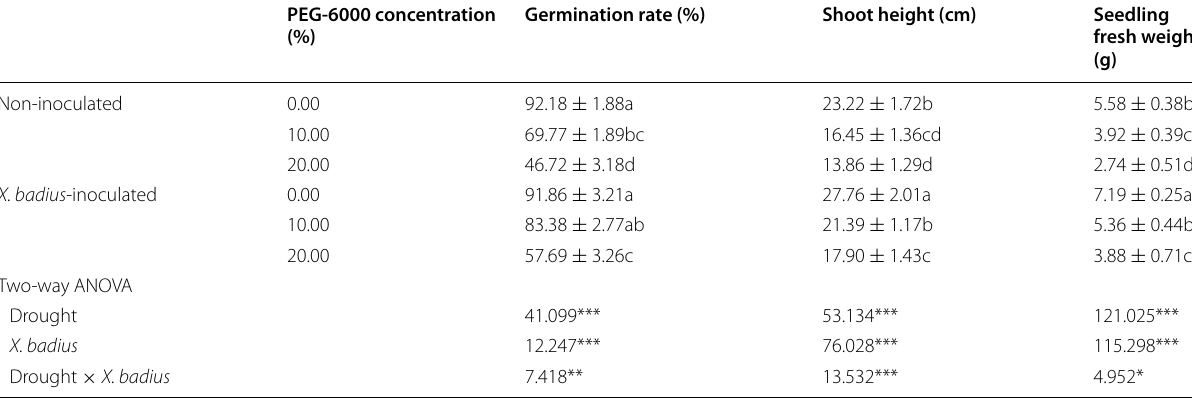
Table 5 Effect of X. badius inoculation on seed germination and seedling growth of L. multiflorum Lam. under different PEG-6000-induced drought conditions